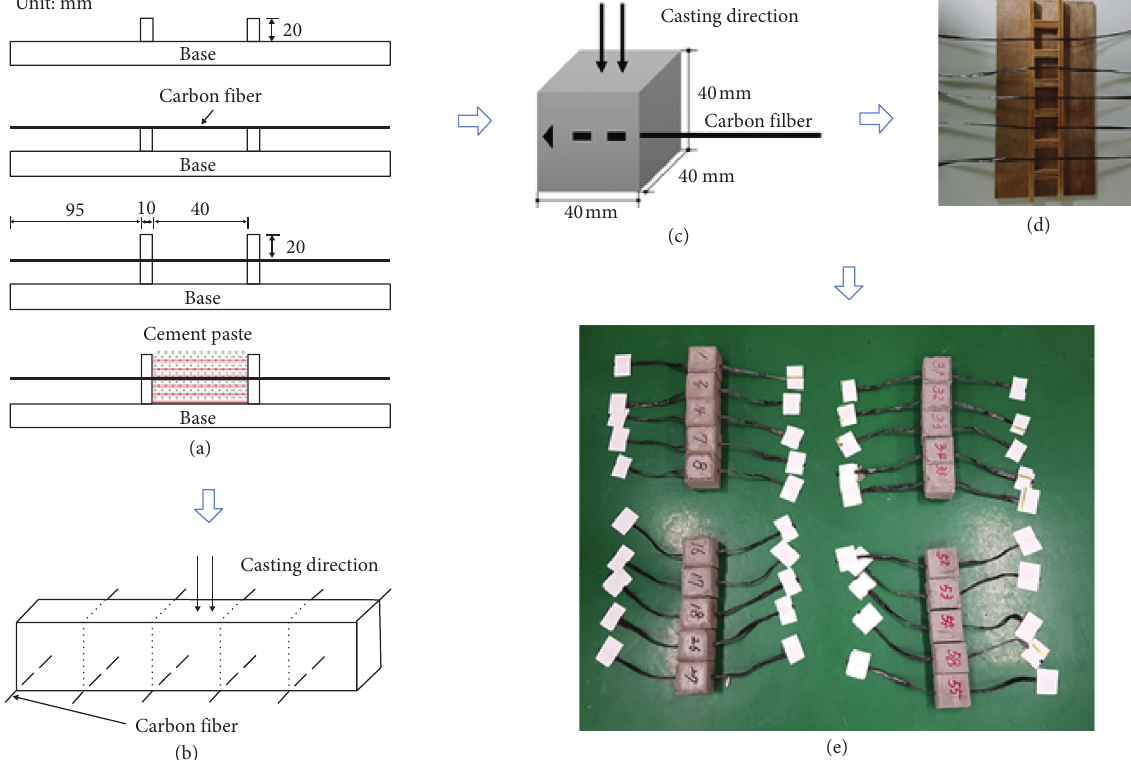
Figure 6: Schematic diagram of the production progress of each step for fabrication specimens of the carbon